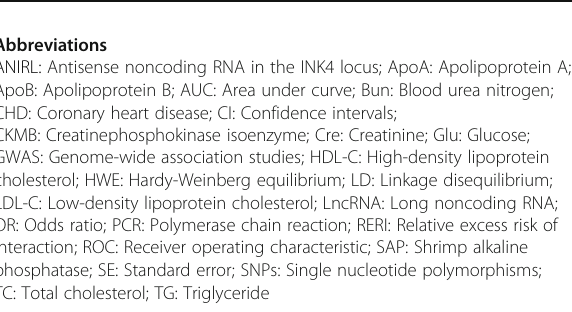
Additional file 1: Table S1. CHD incidence by interactions with environmental factors. Additional file 2: Table S2. Serological biomarkers in the overdominant